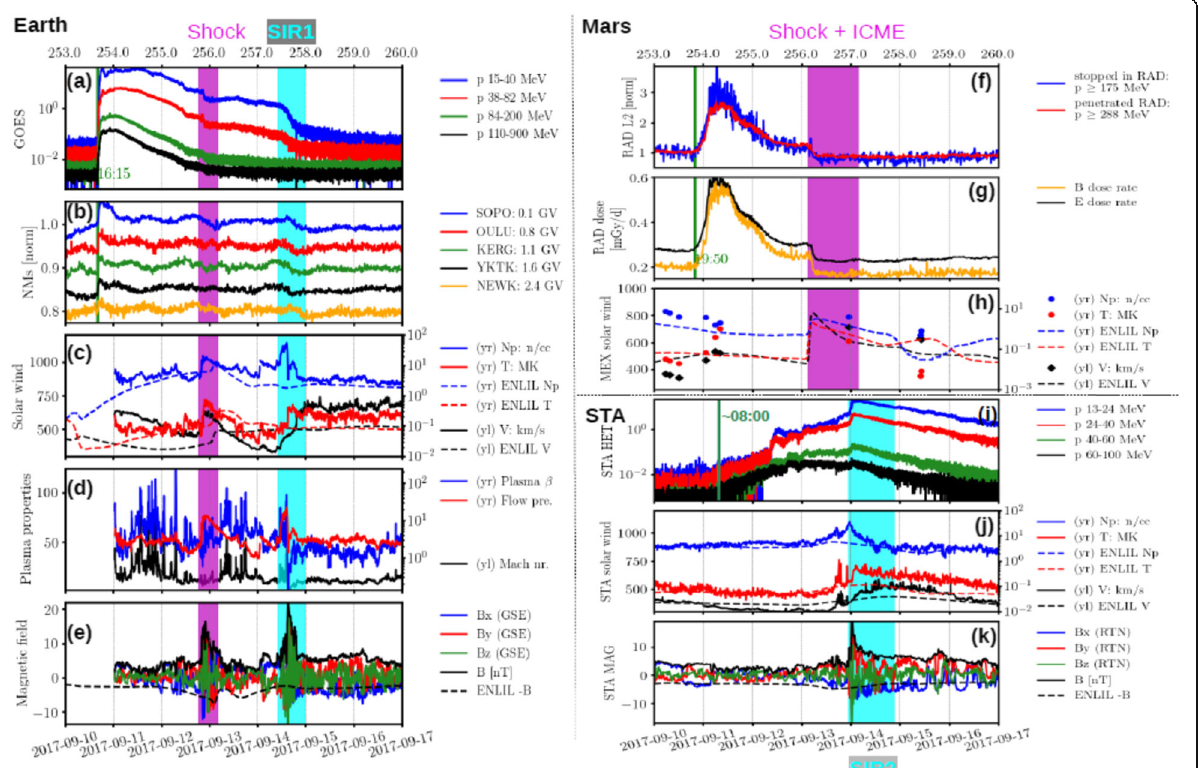
Fig. 9 In situ observations of the 2017-09-10 events at Earth (left panels), Mars ( f-h ), and STA ( i – k ). a , i The energy-dependent particle flux (counts/cm 2 /sr/MeV/sec) measured by GOES and STA. b Count rate of several ground-based neutron monitors with different cut-off rigidities (each neutron monitor data set is normalized to the average value of the selected time range and shifted apart in y-axis). c , h , and j The solar wind speed (black, left Y -axis (yl)), proton density (blue, right Y -axis (year)), and temperature (red, year) for Earth (OMNI), Mars (MEX), and STA, respectively. The ENLIL modeled results at three locations are also plotted as dashed lines. d Plots of the Alfvén Mach number (black, yl), plasma (blue, year), and flow pressure (red, year) estimated at Earth. e , k The vector magnetic fields at Earth/STA in Geocentric Solar Ecliptic (GSE) or spacecraft Radial-Tangential-Normal (RTN) coordinate and negative ENLIL modeled magnetic field strength (dashed line). f The normalized count rate for downward particles stopping in RAD and penetrating RAD with the former/later approximating protons with energies larger than 175/ 288 MeV arriving at Mars. g The dose rate recorded in RAD B (silicon) and E (plastic) detectors. Magenta-highlighted areas are the ICME and/or its associated shock passage at Earth and Mars. Cyan-highlighted areas are high-speed streams (of two different ones) passing Earth and STA during this period. Vertical solid lines in a , b , f , g , and i indicate the particle onset time at Earth/Mars/STA (taken from Guo et al.